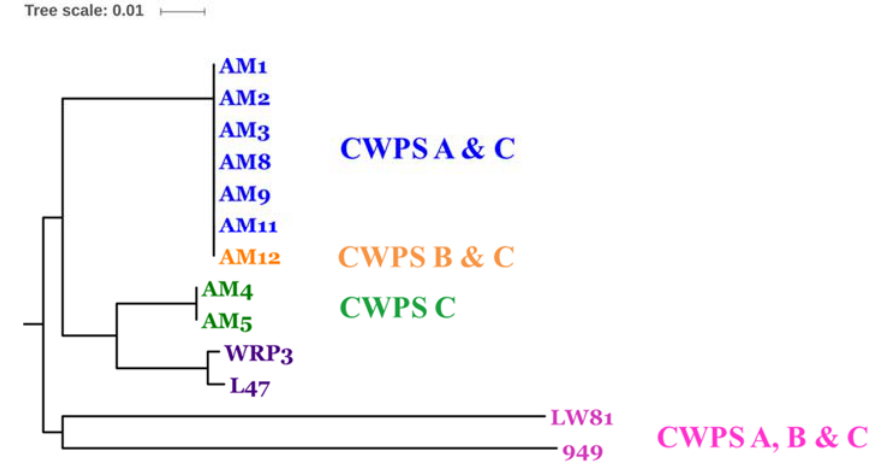
Figure 3. Rooted phylogenetic tree (rooted by the first sequenced member, 949) of the receptor binding proteins (RBPs) encoded by the 949 phage isolates from this and previous studies. The tree was constructed based on a multiple alignment using ClustalW software with the neighbour ‐ joining method with a bootstrap value of 1000. Visualisation of the phylogenetic tree was performed using the ITOL software (http://itol.embl.de/). The names of the phage isolates derived from this study are colour ‐ coded to indicate the cell wall polysaccharide (CWPS) ‐ type presented by host(s) of these phages as indicated in the text, while in purple text are previously described isolates whose host CWPS types were not assessed in this study.